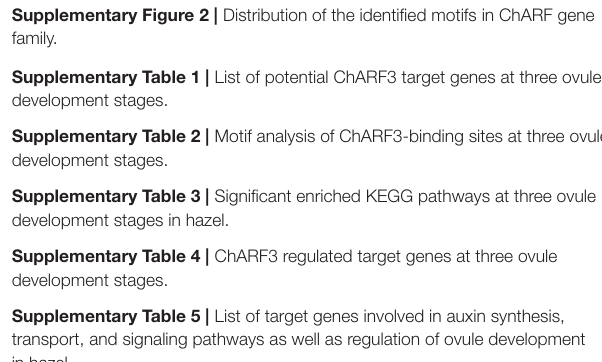
Supplementary Figure 1 | Specificity of polyclonal antibody against ChARF3. Supplementary Figure 2 | Distribution of the identified motifs in ChARF gene